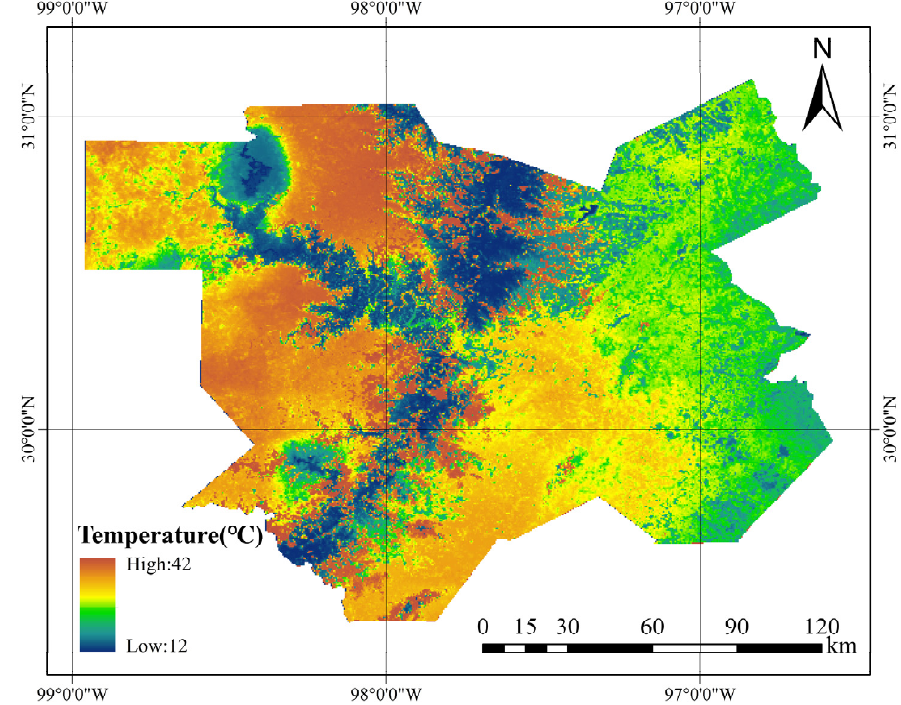
Figure 16. Average temperature distribution for August in Austin, Texas using the Deep Learning model.